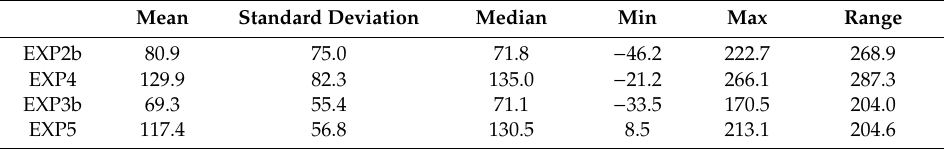
Table 12. RNET (W m − 2 ) simulated by UTOPIA and NOAH, initialized with GLDAS, at the CF station. Mean Standard Deviation Median Min Max Range